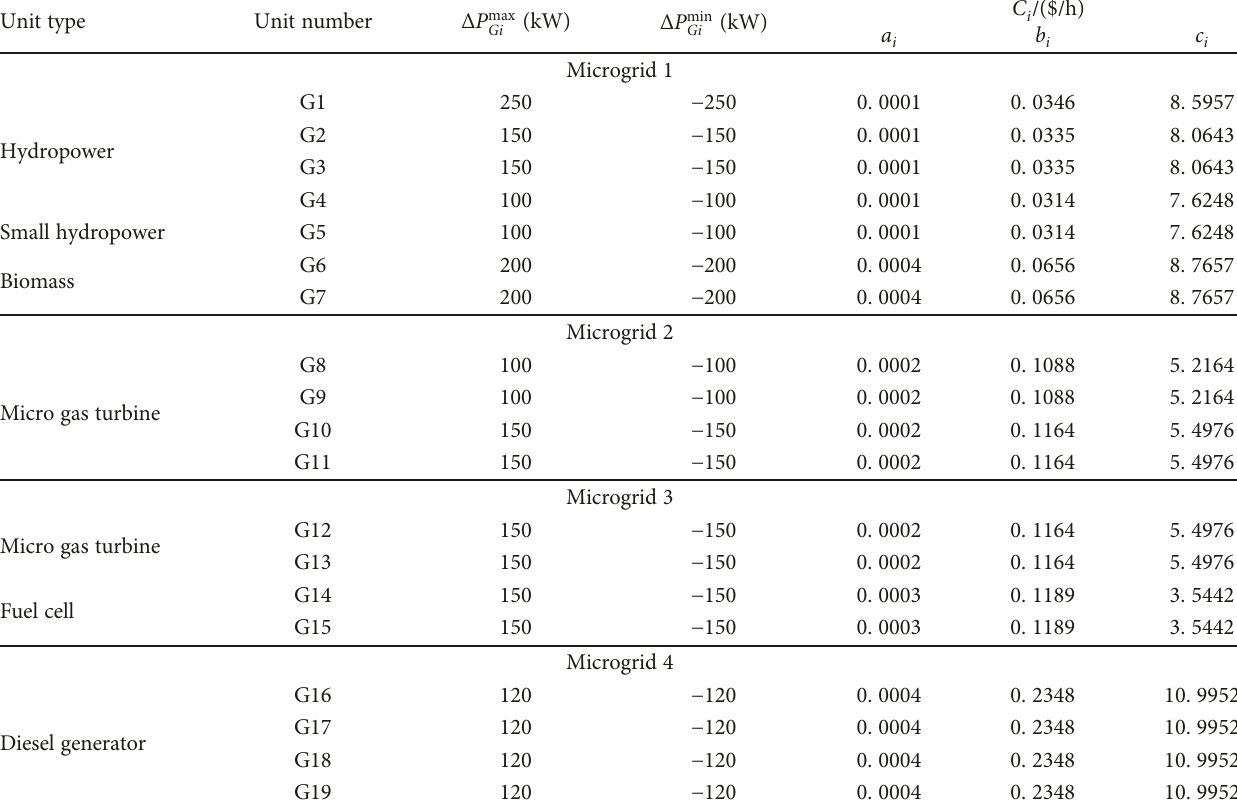
Table 2: System parameters of units used in the islanded smart grid